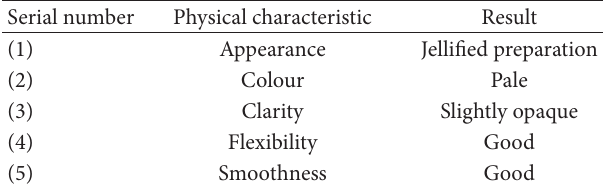
Table 2: Organoleptic characteristics of the prepared patches.